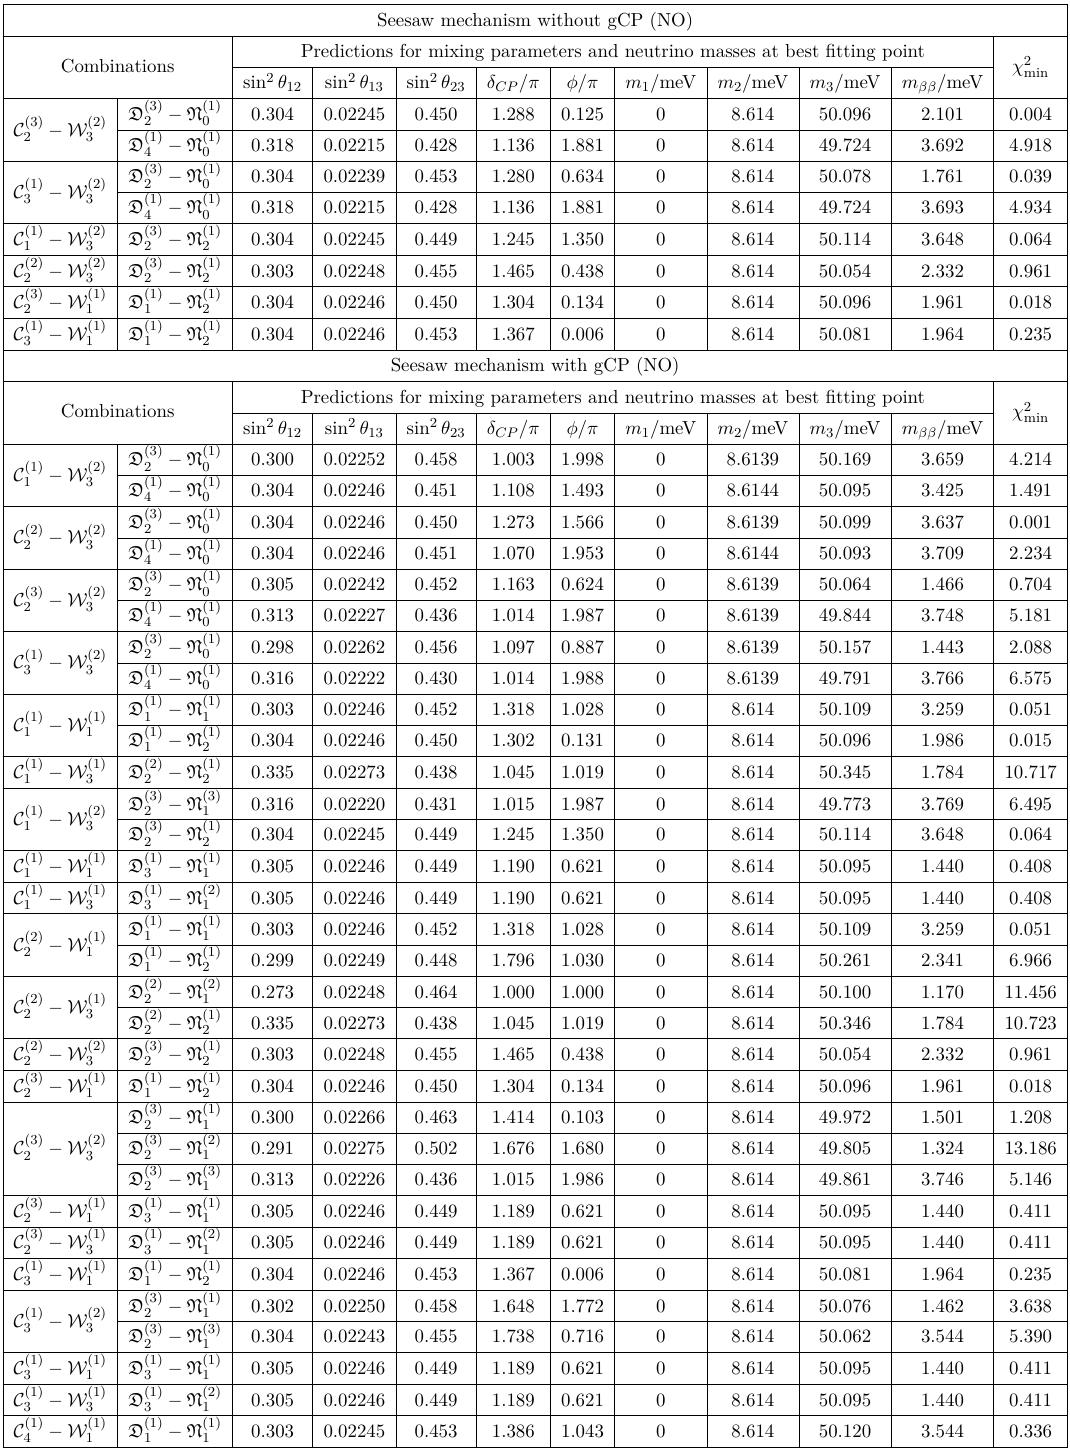
Table 23. Best-fit values of the lepton mixing and neutrino mass parameters for the representative models presented in table 22. For all cases, the predictions of the lepton mass ratios are m 0 . 00474 , m = 0 . 0586 and ∆ m 2 = 0 . 030 / ∆ m 2 µ /m τ 21 31